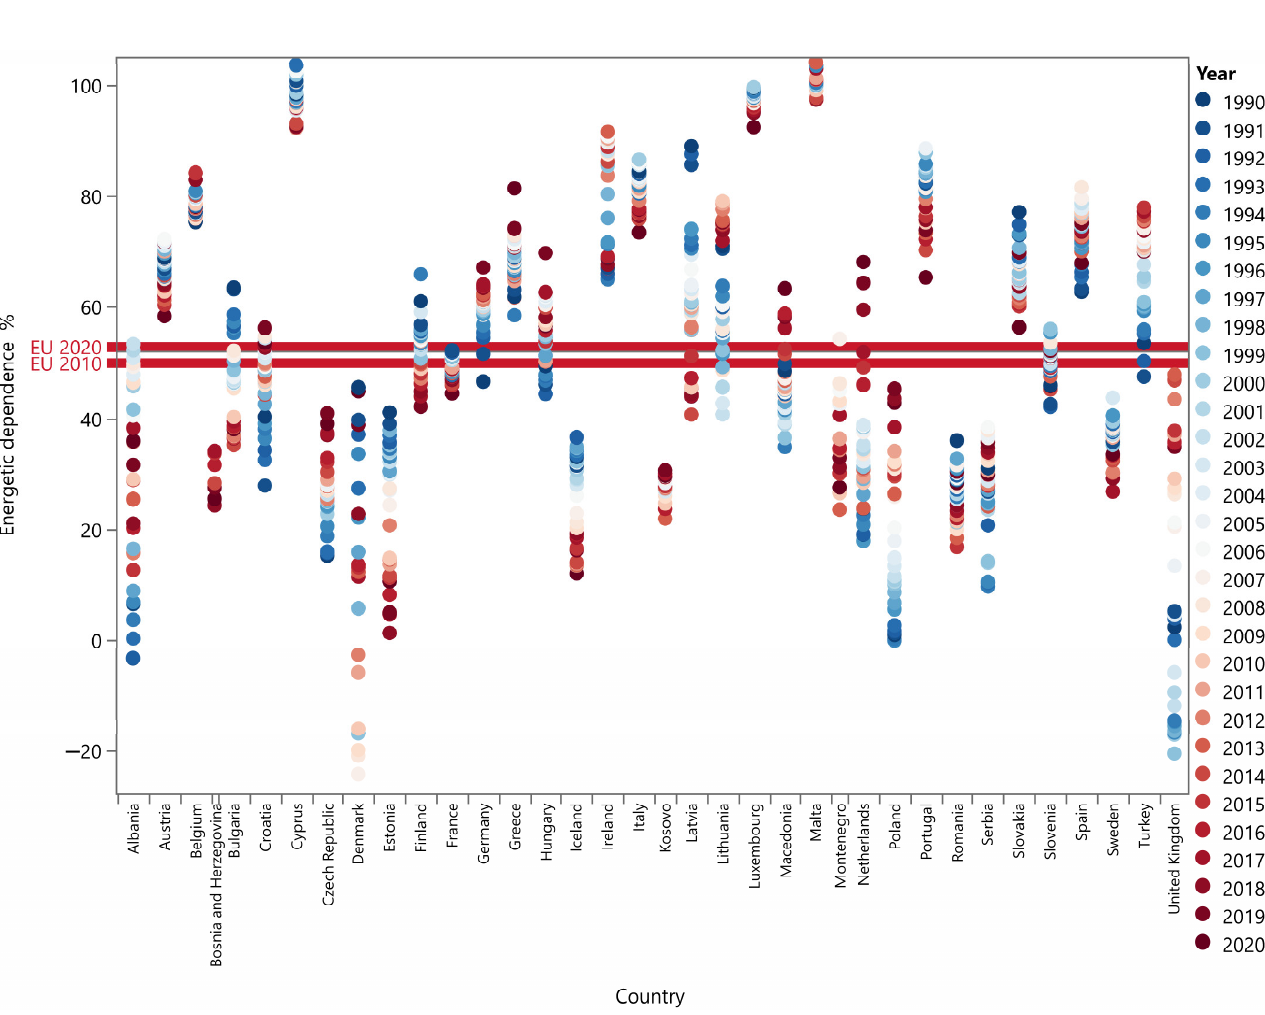
Figure 7. Energy dependence—graphical analysis of the variability according to EU member states,